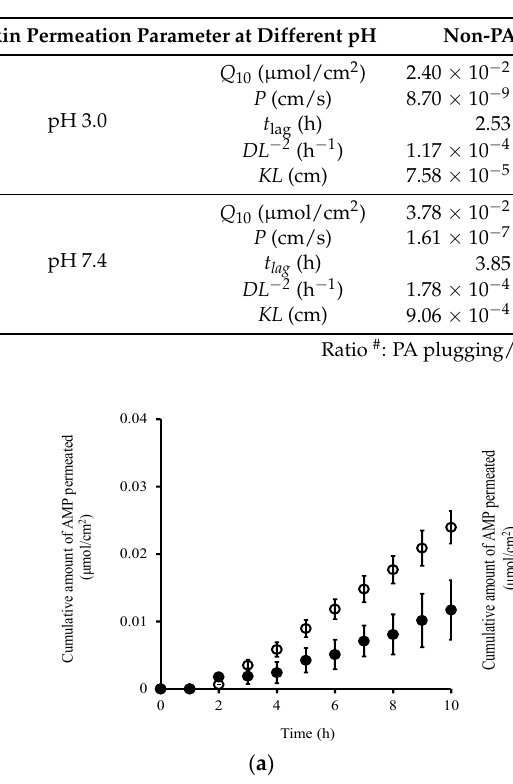
Table 3. Skin permeation parameters and reduction ratio of AMP with or without hair follicle-plugged skin.